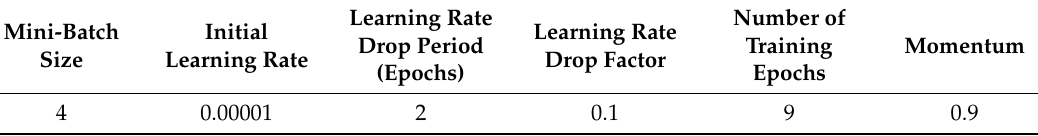
Table 3. Parameters of SGD method for training the stacked CNN-RNN network in our